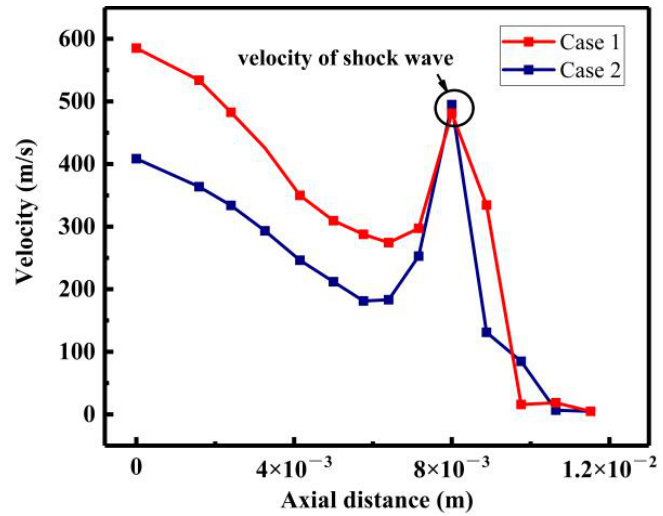
Figure 7. The axial distribution of velocity in case 1 at 807 μs and case 2 at 2407 μs